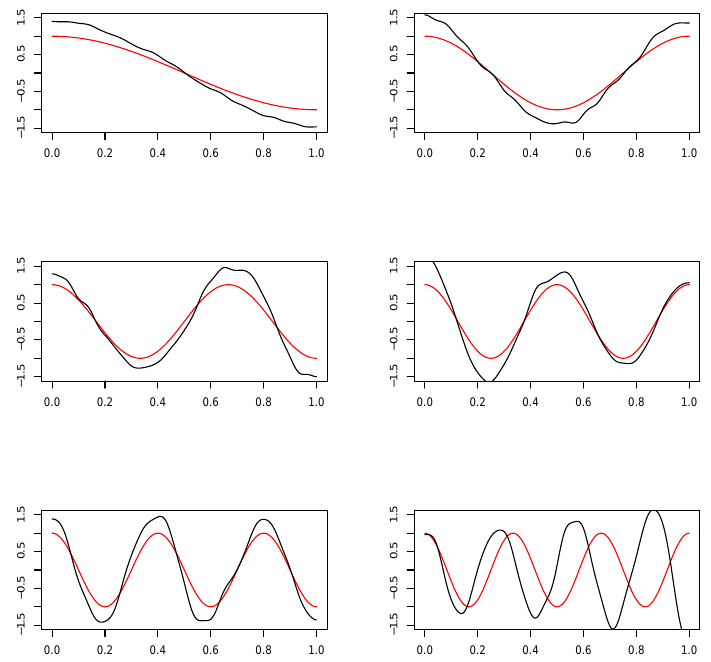
Figure 4. True basis functions (red) and “reconstructed” basis functions (black) using fPCA